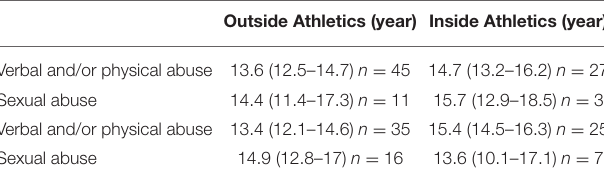
TABLE 7 | Type and distribution of first abuse perpetrators outside and inside the Athletics